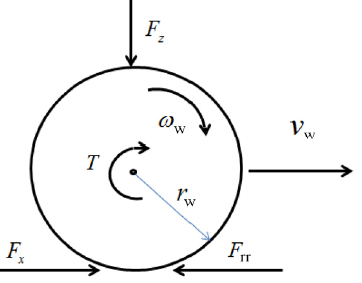
Fig. 7 Free body diagram of a single